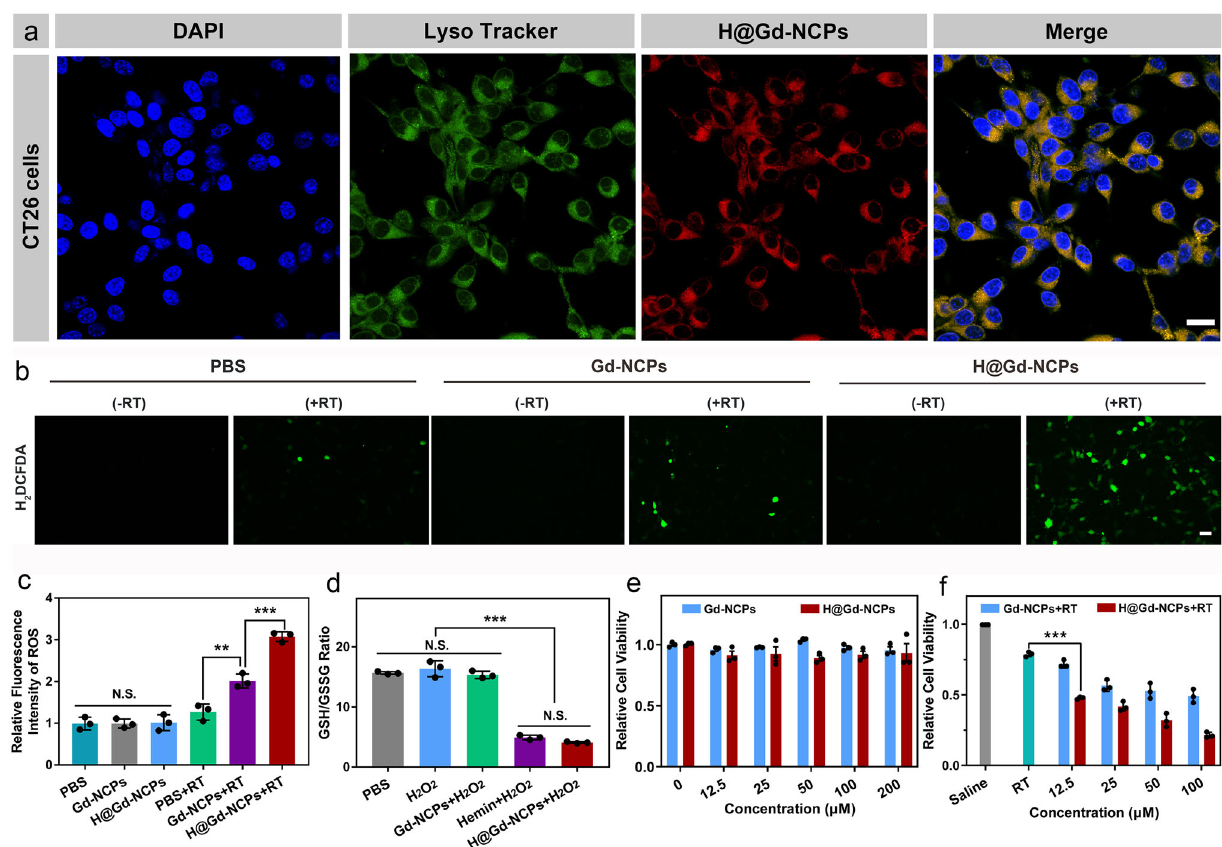
Fig. 3 Cellular uptake and radiosensitization of H@Gd-NCPs in vitro. a Confocal laser scanning microscope (CLSM) images of CT26 cells after treatment with DAPI, Lysotracker and H@Gd-NCPs, respectively. Yellow regions indicated localization of H@Gd-NCPs in the lysosomes, scale bar = 20 μ m. b Fluorescence images of CT26 cells treated with PBS, Gd-NCPs, and H@Gd-NCPs with or without 8 Gy × 1 irradiation and detected with a reactive oxygen species (ROS) probe H 2 DCFDA (green fl uorescence) for intracellular ROS evaluation, scale bar = 200 μ m. c Quanti fi cation of fl uorescence based on ( b ) by ImageJ software ( n = 3 biologically independent cells, ** p = 0.0071, *** p = 0.0008). d PBS, Hemin, Gd-NCPs and H@Gd-NCPs decrease intracellular GSH/GSSG ratios in CT26 cells ( n = 3 biologically independent cells, *** p = 0.0001). e The cytotoxicity of Gd-NCPs and H@Gd-NCPs without